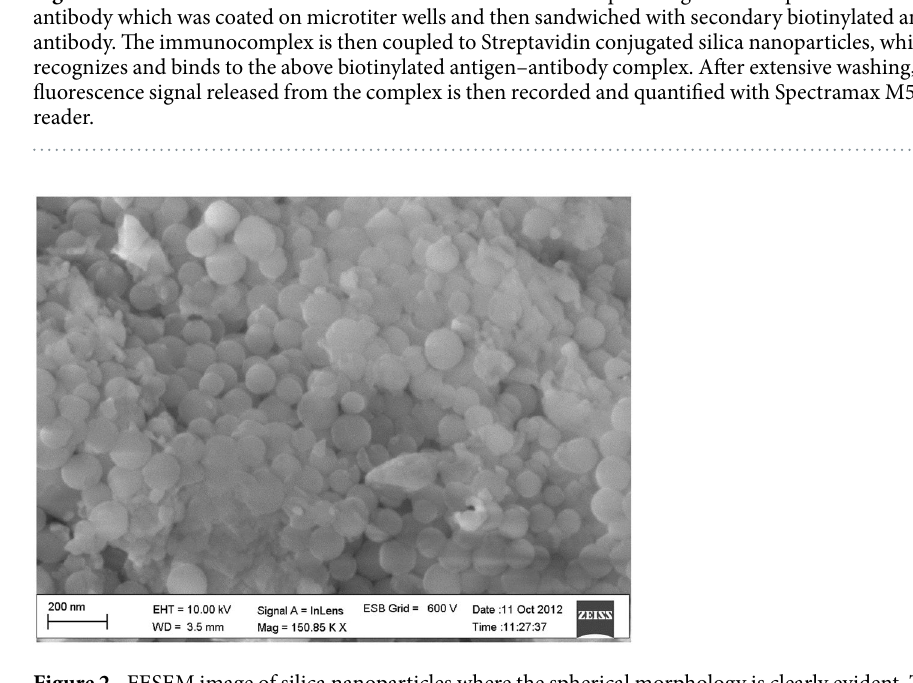
Thermogravimetric Analysis. Thermogravimetric analysis (TGA) was performed to assess the extent of surface modification. TGA was carried out in air at a heating rate of 10 K min − 1 till 800 °C using Mettler Toledo, TGA/ DSC 1. Figure 3(b) shows the weight loss curves of annealed SiO 2 :Eu, SiO 2 :Eu-NH 2 , and SiO 2 :Eu-COOH respec- tively. The weight loss of all the samples was calculated and tabulated in Table 1. All the three samples exhibited two step weight losses. The first weight loss below 120 °C was due to the evaporation of physically adsorbed water and the second weight loss from 120 °C to 800 °C was attributed to the decomposition of organic matter. The weight loss for SiO 2 sample was 2.91% and considered as reference for the calculation of surface functional groups of the other two samples. Decomposition of amino propyl groups led to higher weight loss (6.7%) in SiO 2 -NH 2